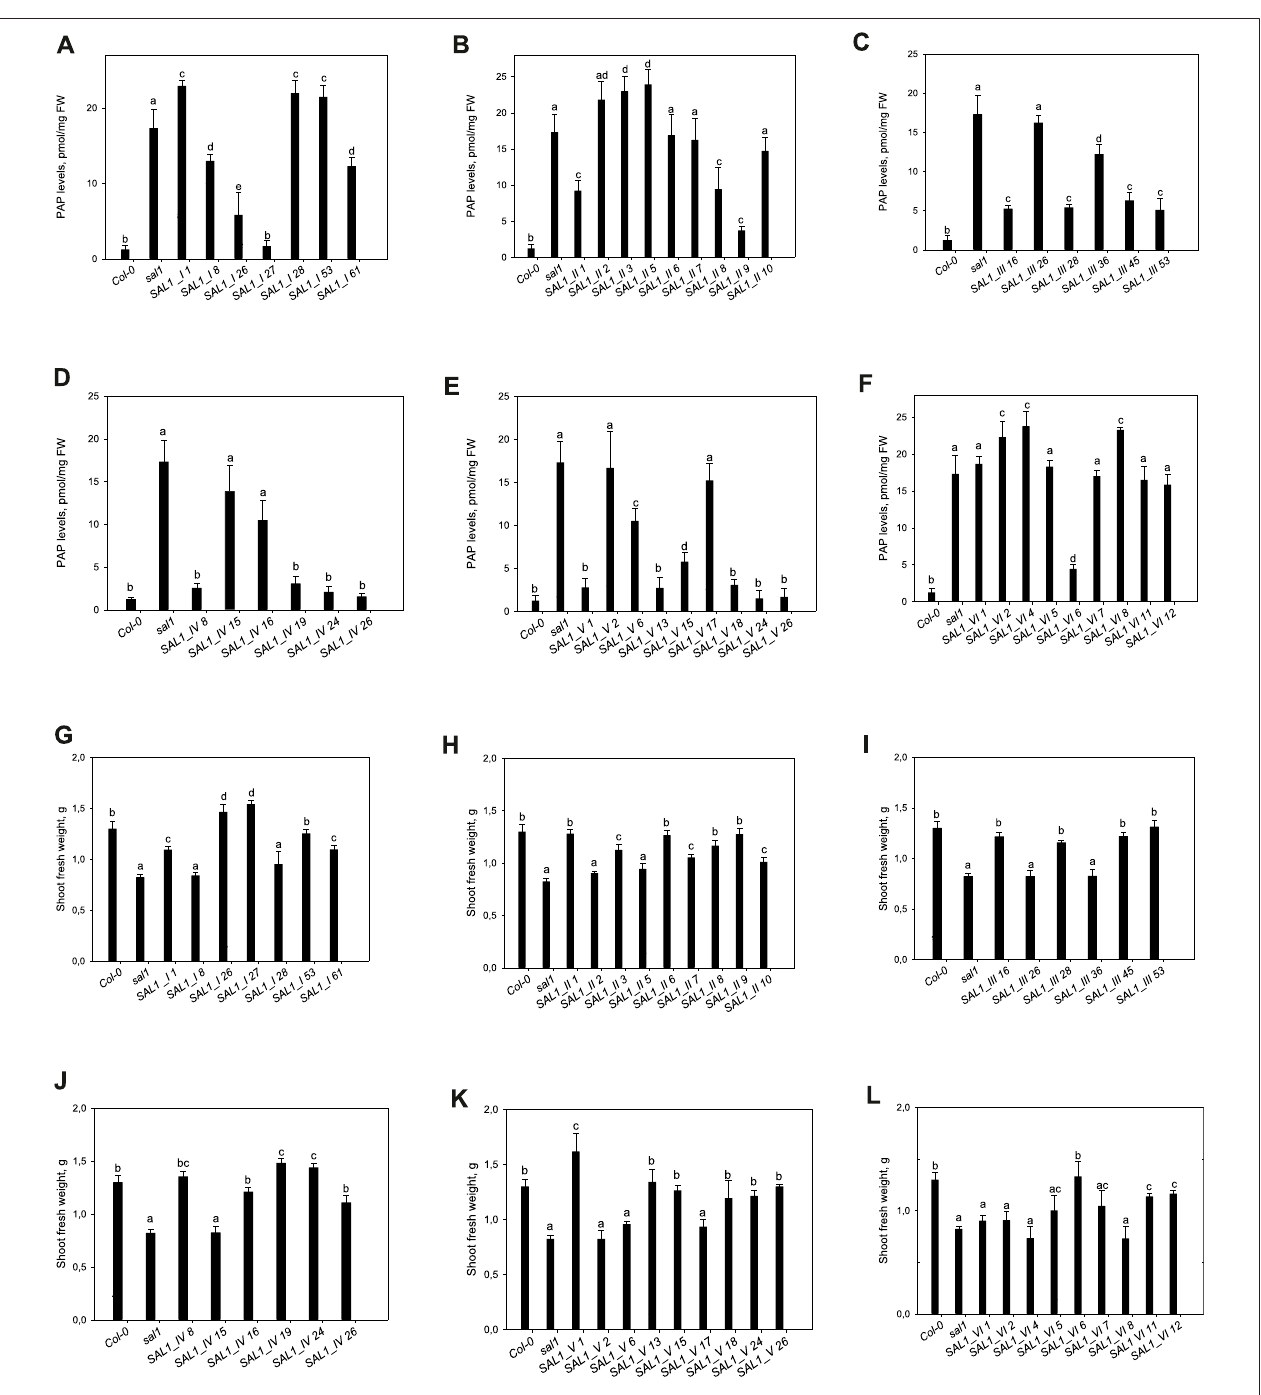
FIGURE 5 | Phosphoadenosine 5 ′ -phosphate (PAP) levels and shoot fresh weight in sal1 mutants with the directed expression of SAL1 to various cell compartments. (A – F) PAPlevelsinrosetteleavesof5-week-old SAL1 andstablytransformed sal1 transgenicplantsoverexpressingSAL1chimericproteins. (A) SAL1_I (nuclear localization). (B) SAL1_II (cytosolic localization). (C) SAL1_III (chloroplastic localization). (D) SAL1_IV (mitochondrial localization). (E) SAL1_V (chloroplastic and mitochondriallocalization). (F) SAL1_VI (nuclearandcytosoliclocalization).Plantsweregrownonsoilinshortdaysinacontrolledenvironmentchamber.Datashow the mean ± SD ( n (cid:1) 3). FW , fresh weight. Different letters indicate signi fi cant differences among means based on t -tests at p < 0.05. (G – L) Shoot fresh weight of sal1 mutants complemented with SAL1 expressed in different cell compartments. Shoot fresh weight of wild-type, sal1 , and stably transformed sal1 transgenic plants overexpressing SAL1 chimeric proteins. (G) SAL1_I (nuclear localization). (H) SAL1_II (cytosolic localization). (I) SAL1_III (chloroplastic localization). (J) SAL1_IV (mitochondrial localization). (K) SAL1_V (chloroplasticand mitochondrial localization). (L) SAL1_VI (nuclear and cytosolic localization). Plants were grown for 4 weeks on MS agar plated under short-day conditions in an environment-controlled chamber. Data show the mean ± SD ( n (cid:1) 9). Different letters indicate signi fi cant differences among means based on t -tests at p < 0.05.